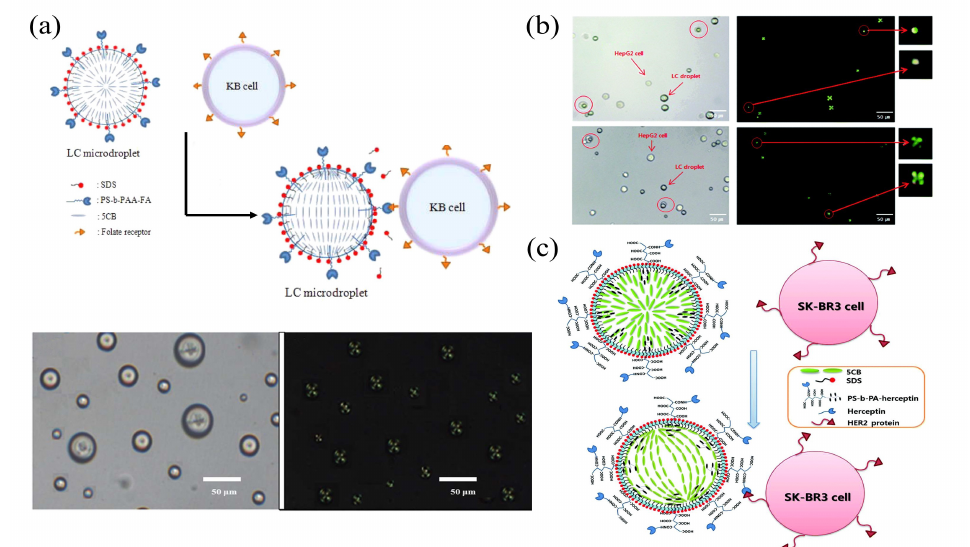
Figure 6. ( a ) Illustration of the configuration transition and POM images of LC droplets containing PS- b-PAA-FA with KB cancer cells [108]; reproduced with permission from American Chemical Society. ( b ) Optical and polarization images of HepG2 cells in contact with β -galactose-(PS-b-PA-G) anchored LC droplets [109]; reproduced with permission from Royal Society of Chemistry. ( c ) Illustration of herceptin–HER2-interaction-induced configuration transition in LC droplets [110]; reproduced with permission from Royal Society of